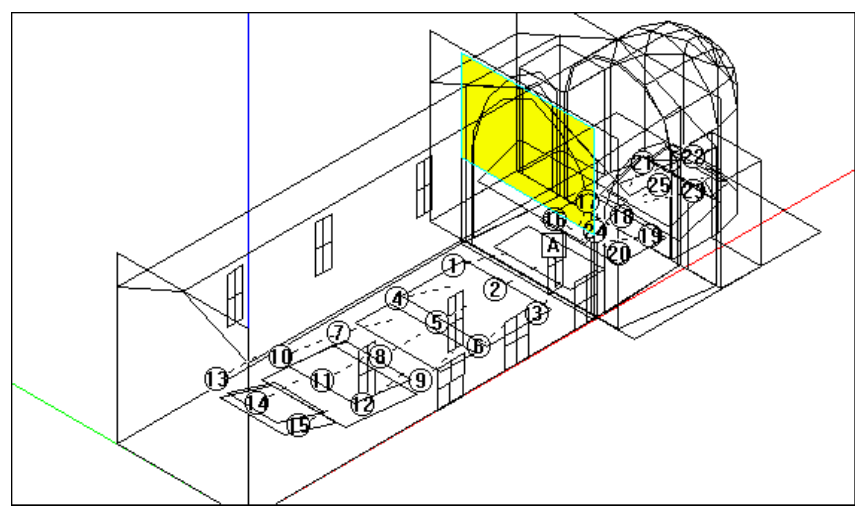
Figure 13. Transparent panel closing the arch dividing the transept area from the nave.